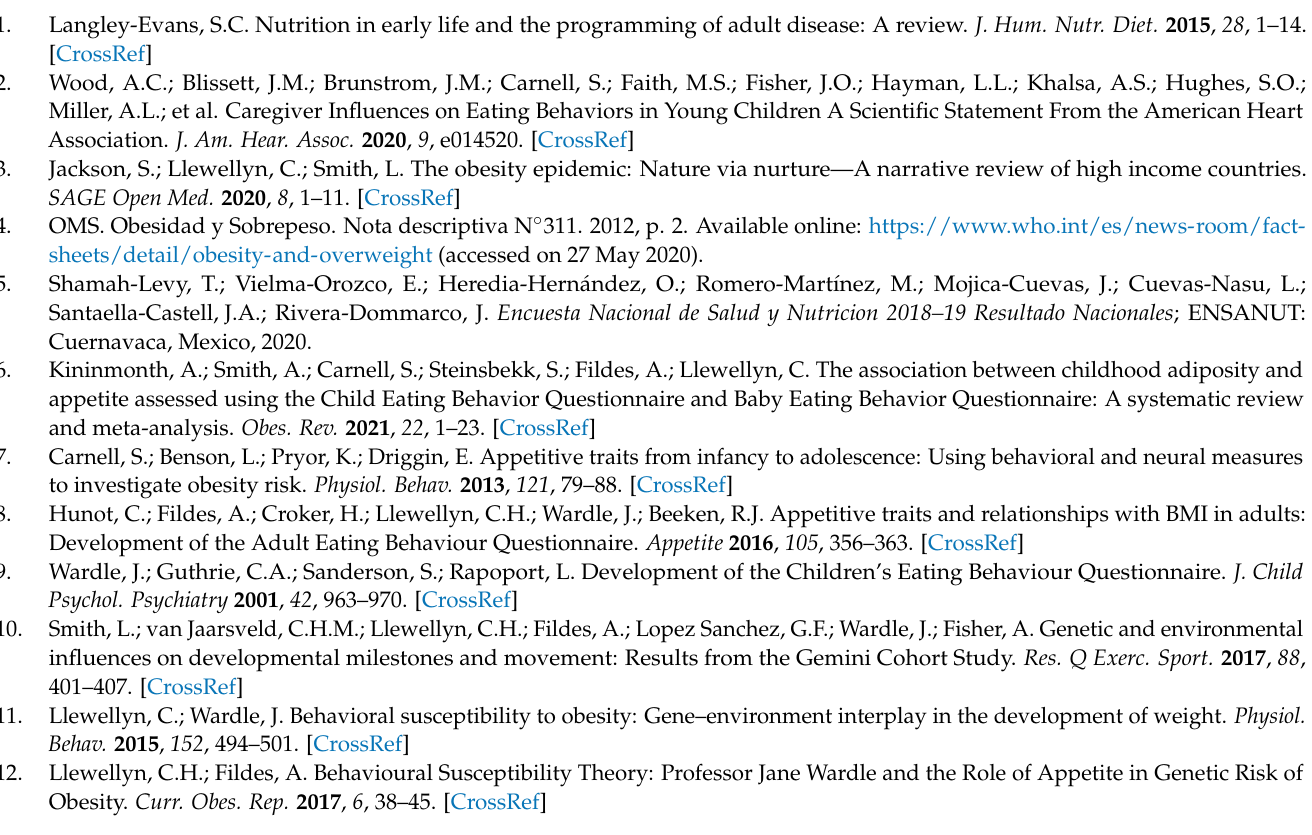
correlations, and error covariances) fitted in a sample of 330 mother–infant dyads (Model 1: left panel, Model 2: right panel); Figure S2: Path diagram of the six-factor model of the CEBQ-T-Mex with standardized estimates (factor loadings, item squares multiple correlations, and error covariances) fitted in a sample of 330 mother–toddler dyads; Table S4: Linear regressions between infant and toddler appetitive traits and BMI-z adjusting for sex, age, and feeding